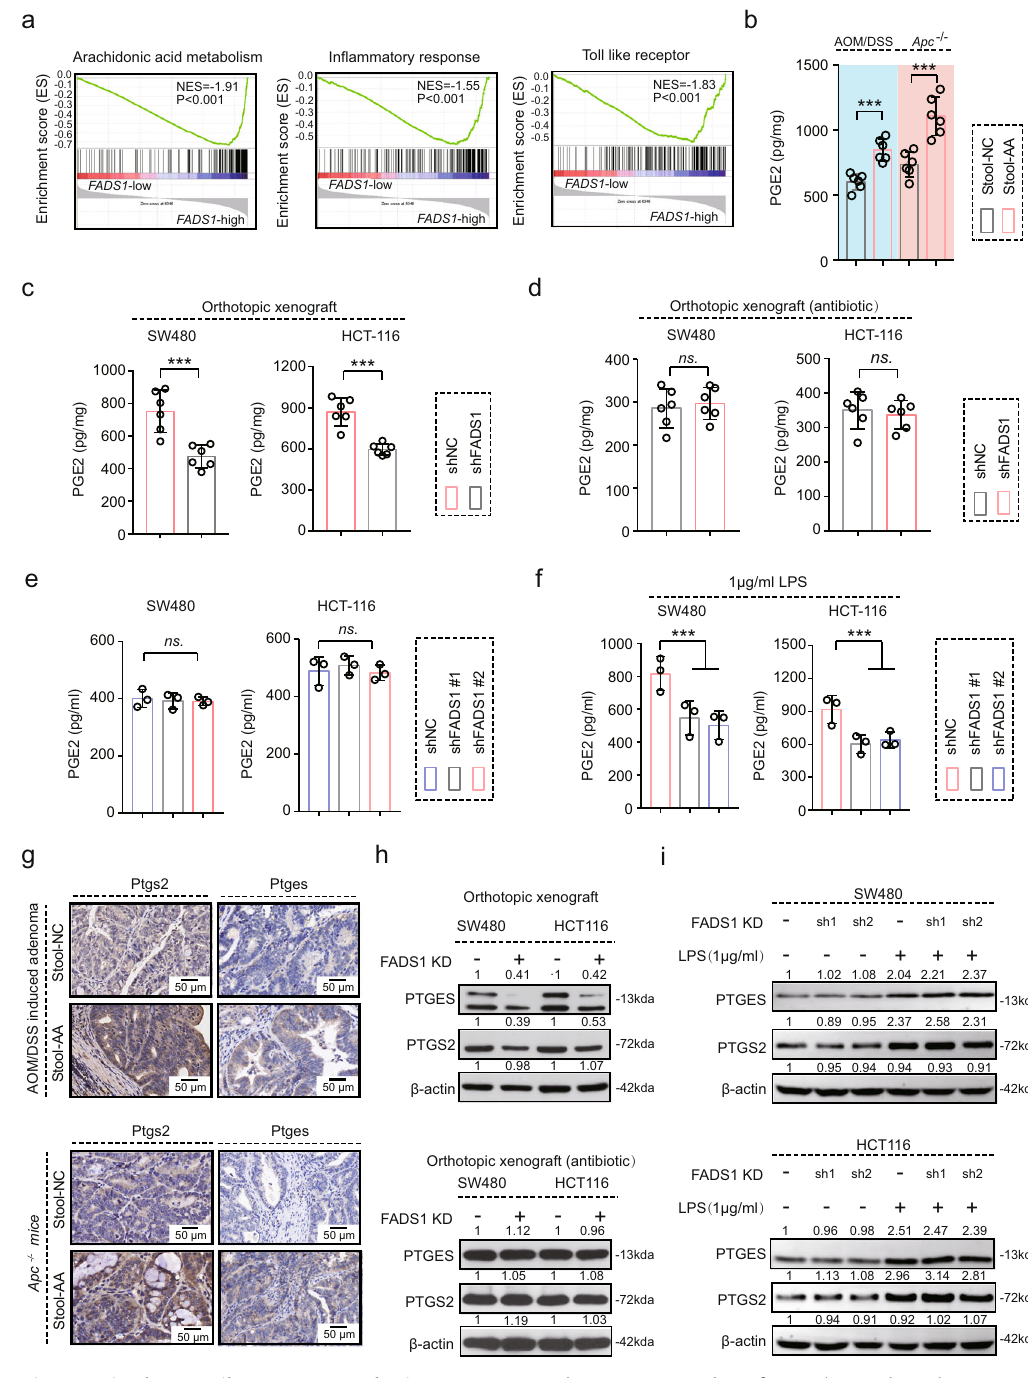
Fig. 5 | Gram-negative gut microbes contribute to PGE2 production. a GSEA analysisof FADS1 expressioninCRC,asevaluatedfromtheTCGAdataset(440CRC samples) and divided into high and low FADS1 expression (220 samples each) groups. NES, normalized enrichment score, p , statistical signi fi cance. b PGE2 level in the tumor tissues of AOM/DSS or intestine-speci fi c Apc − / − mice with fecal trans- plantsofNCorAAfeeding( n =6micepergroup,means±s.d.;two-tailedunpairedt test, n =3technicalreplicates).*** p <0.001. c PGE2levelsinthetumortissuesofthe orthotopic tumors induced by SW480 and HCT116 cells transfected with sh FADS1 or shNC ( n =6 mice per group, means ± s.d.; two-tailed unpaired t test, n =3 technicalreplicates).*** p <0.001. d PGE2levelintheorthotopictumorsinducedby SW480 and HCT116 cells transfected with sh FADS1 or shNC, gut microbes elimi- nated with quadruple antibiotics ( n =6 mice per group, means ± s.d.; two-tailed unpaired t test, n=3 technical replicates). ns indicates no statistical signi fi cance. e PGE2 levels in SW480 and HCT116 cells transfected with sh FADS1 or shNC. ns